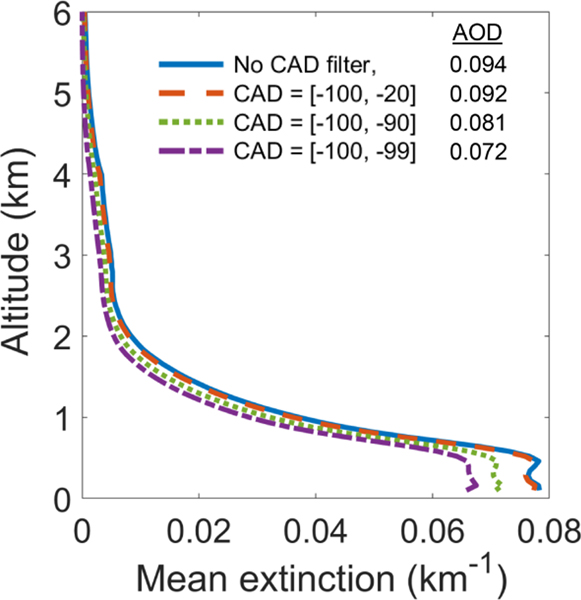
Mean extinction without the CAD score filter (blue solid line) and with three different CAD score ranges (dashed lines) for 2010, at night, all-sky, ocean-only, 50° S–50° N.